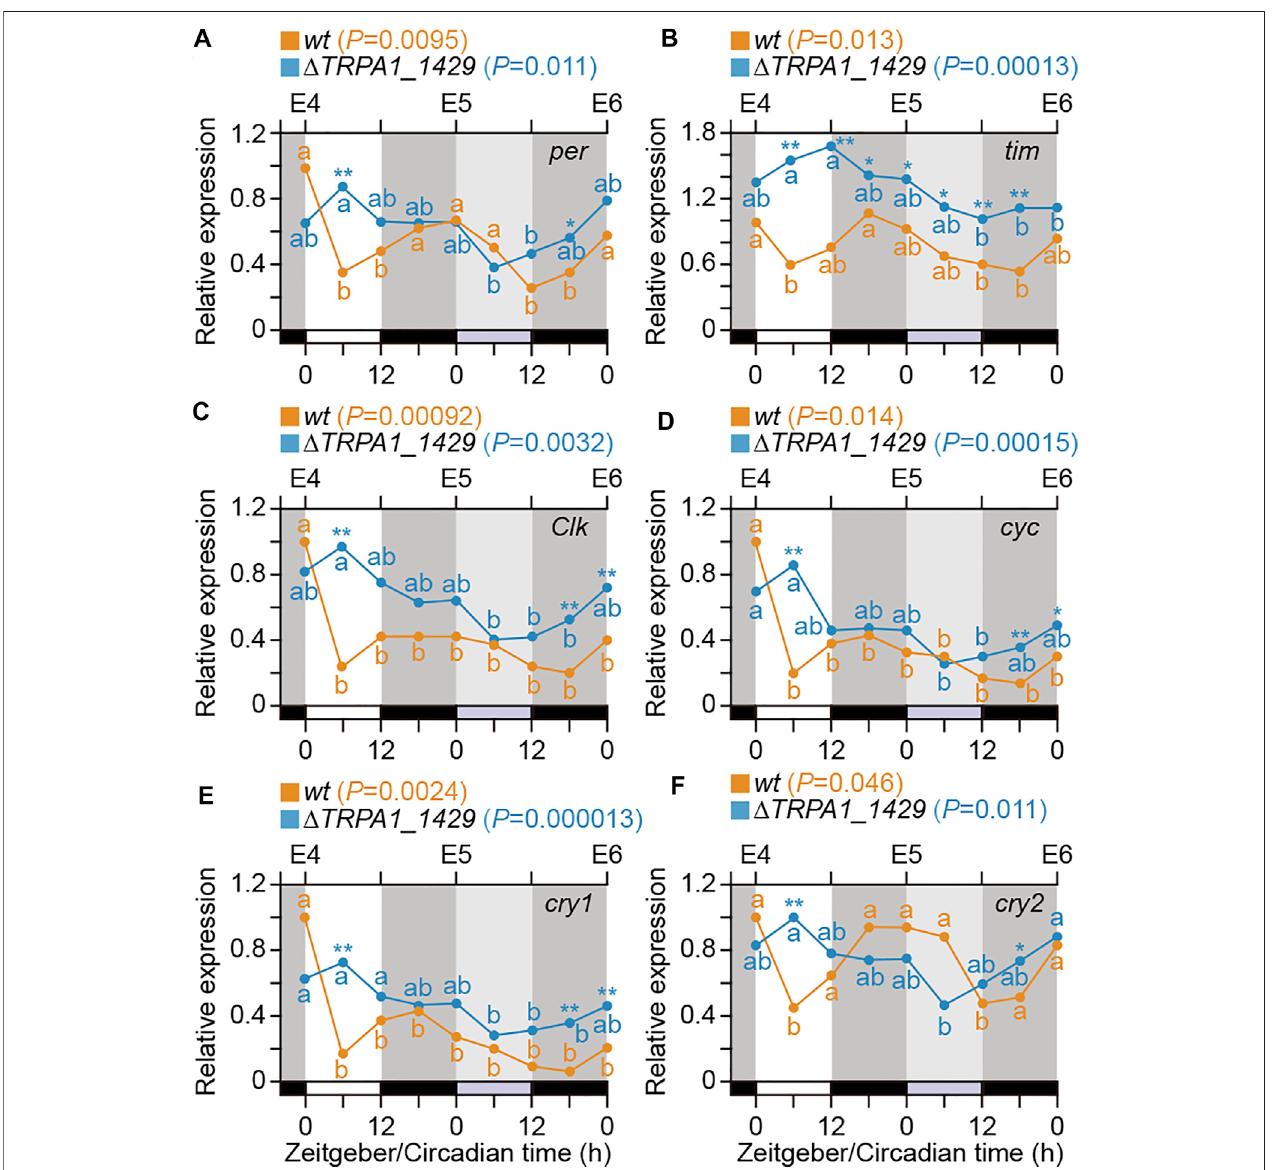
FIGURE 4 | Temporal expression patterns of clock genes in eggs. Temporal pro fi les of clock gene expression in eggs of wt (orange line) and BmoTRPA1 ( Δ TRPA1_1,429 ) knockout mutants (blue line) during 4 – 6 days (E4~E6) after oviposition. Eggs were incubated under 12-h light/12-h dark (12L12D) conditions at 25 ° C and collected at 6-h intervals for a 1-day cycle (ZT0 – 24) and the following day in constant darkness (DD; circadian time; CT0~24). mRNA levels of period [ per ] (A) , timeless [ tim ] (B) , Clock [ Clk ] (C) , cycle [ cyc ] (D) , cryptochrome1 [ cry1 ] (E) , and crtyptochrome2 [ cry2 ] (F) were determined by qPCR. Each value is the mean from four sets of eggs. Open bars, light; black bars, dark; gray bars, subjective day. Using one-way analysis of variance (ANOVA), p values are represented in each usage guide of wt and Δ TRPA1_1,429 in each panel. Different lower-case letters indicate values that are signi fi cantly different from each other in each wt (Orange) and Δ TRPA1_1,429 (Blue) [Tukey – Kramer test]. Signi fi cant differences ( wt vs. Δ TRPA1_1,429 in each stage) are represented by an asterisk (Student ’ s t -test). * p < 0.05; ** p <